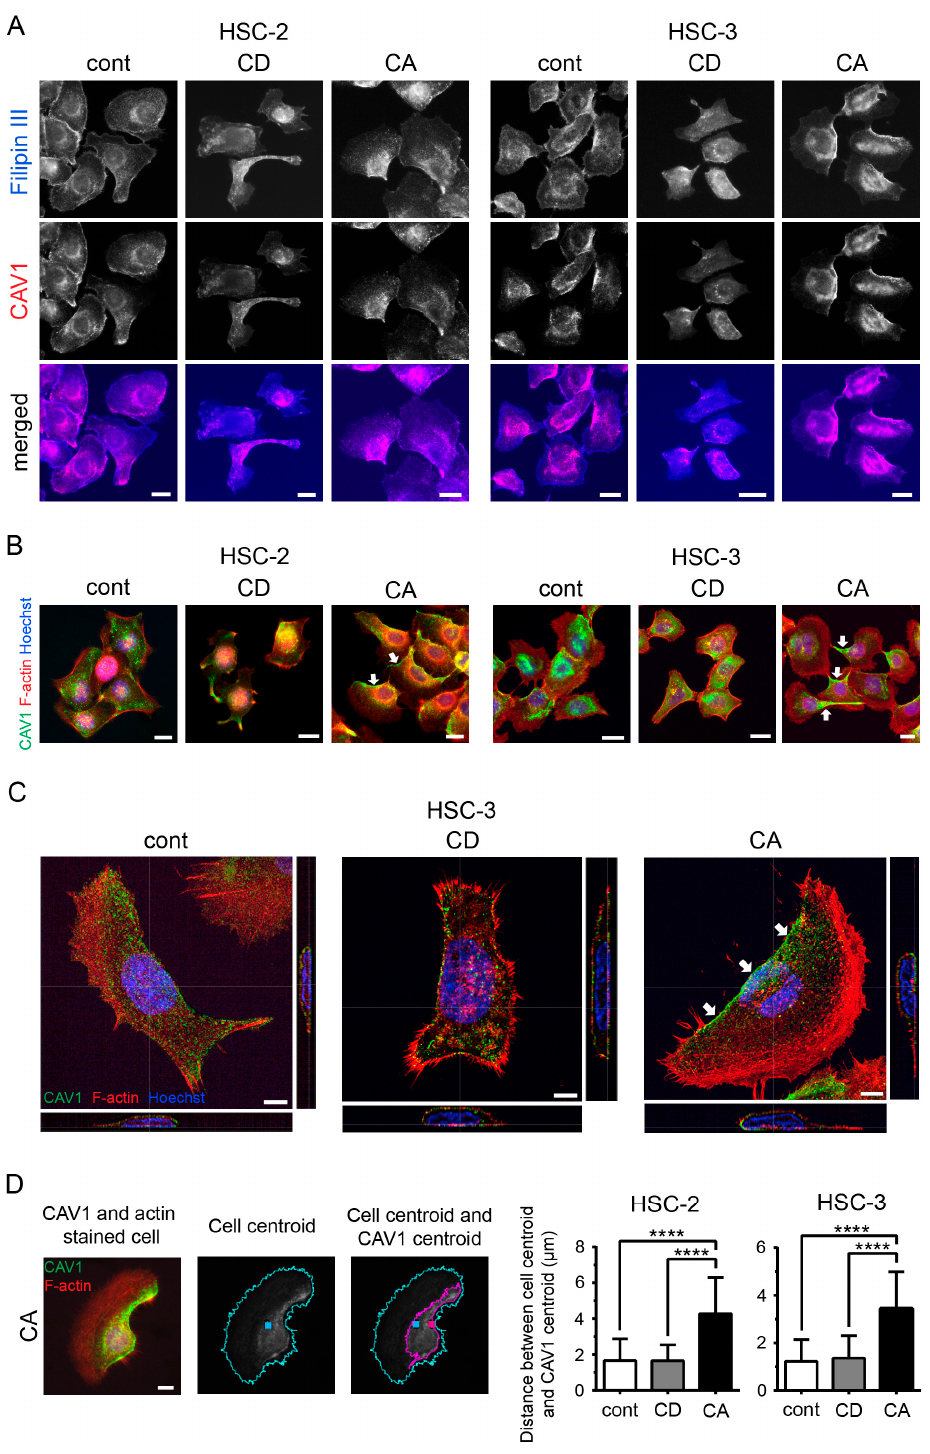
Figure 2. Cholesterol promotes asymmetric membranous localization of CAV1. ( A ) Colocalization of filipin III and CAV1. Blue, filipin III; red, CAV1. Scale bars, 20 µm. ( B ) Fluorescence staining for CAV1 and F-actin. Green, CAV1; red, F-actin; blue, Hoechst. Scale bars, 20 µm. Arrows indicate the asymmetric localization of CAV1. ( C ) CAV1 distribution assessed using confocal microscopy. Green, CAV1; red, F-actin; blue, Hoechst. Scale bars, 5 µm. Arrows indicate the asymmetric localization of CAV1. ( D ) Assessment of CAV1 distribution by centroid position. Cell centroid (blue square) and CAV1 centroid (red square) of CAV1- and actin-stained cells (N ≥ 50) were determined using ImageJ. The distance between the two points was measured using ImageJ software. Scale bar, 10 µm. Bar graphs represent the distance as mean ± SD. **** p < 0.0001.